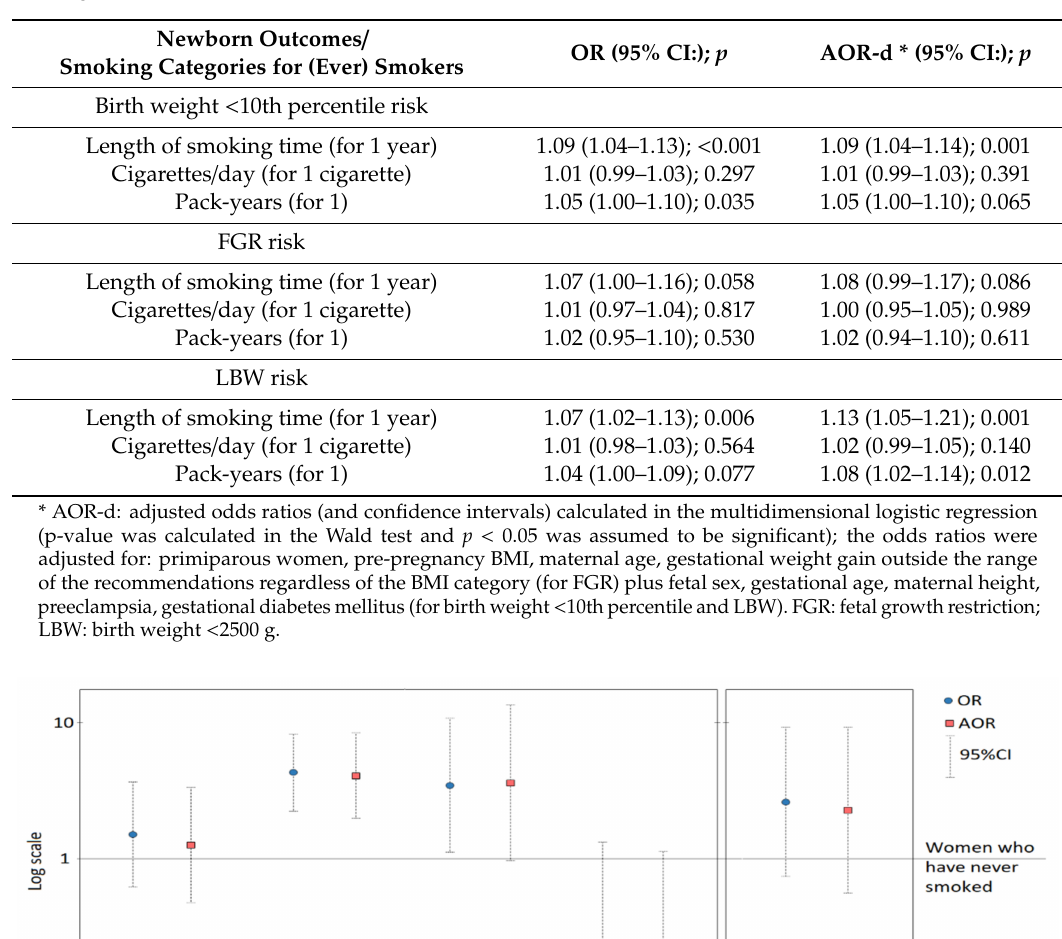
Table 4. The adjusted odds ratios of birth weight < 10th percentile, FGR, and LBW for smoking categories (continuous variables).